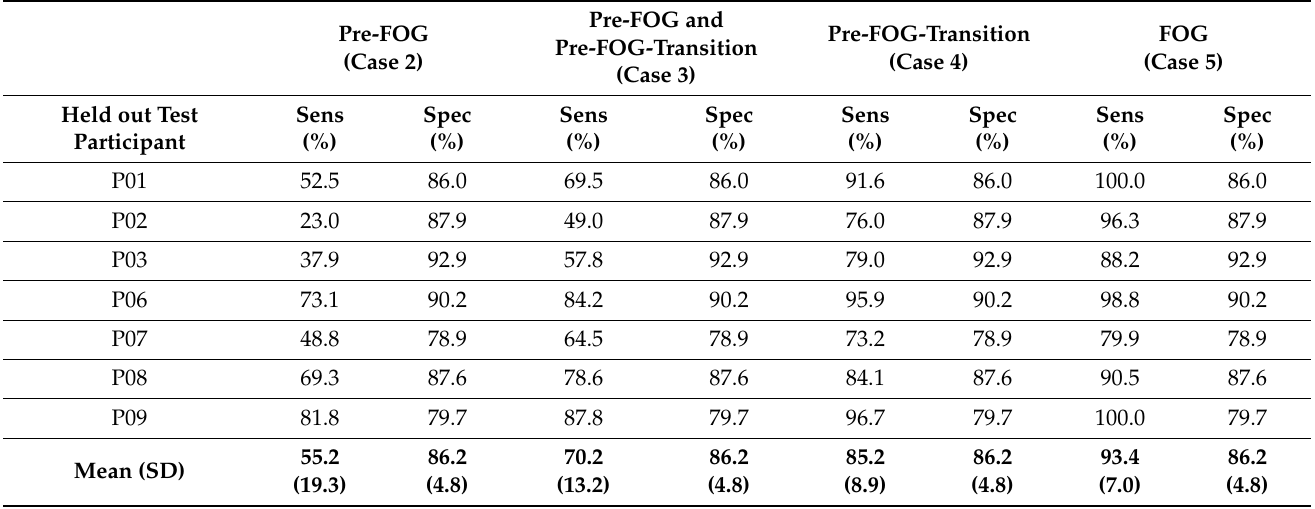
Table 6. Target class test cases for PP-IMU features model, using top 10 features according to Relief-F. Column headers are the label(s) included in the target class, as defined in Table